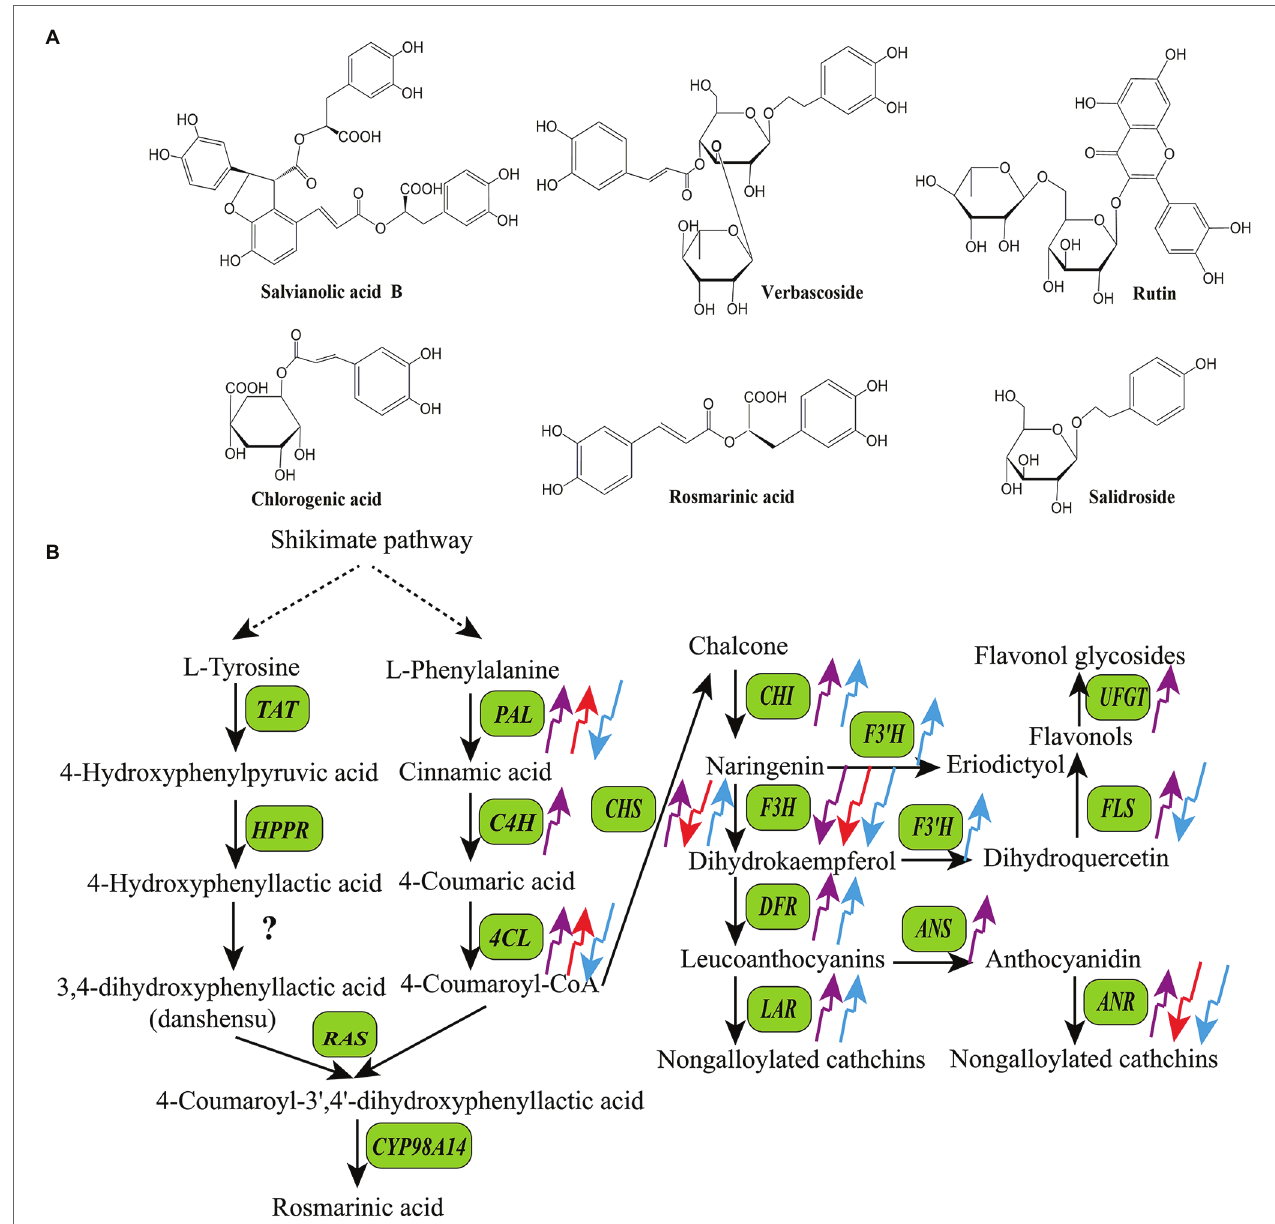
FIGURE 1 | Structures of some bioactive polyphenols in medicinal plants (A) and the effects of light quality on the transcripts of key enzyme genes in the biosynthetic pathways of polyphenols (B) . The upward arrows indicate upregulation and the downward arrows indicate downregulation. The purple arrow, red arrow, and blue arrow indicate UV-B, red light, and blue light, respectively. ANR , anthocyanidin reductase; ANS , anthocyanidin synthase; CHS , chalcone synthase; CHI , chalcone isomerase; CYP98A14 , cytochrome p450 98A14; C4H , cinnamic acid 4-hydroxylase; DFR , dihydroflavonol 4-reductase; FLS , flavonol synthase; F3 ′ H , flavonol 3 ′ -hydroxylase; F3H , flavanone 3-hydroxylase; HPPR , 4-hydroxyphenylpyruvate reductase; LAR , leucoanthocyanidin reductase; PAL , phenylalanine ammonia-lyase; RAS , rosmarinic acid synthase; TAT , tyrosine aminotransferase; UFGT , UDP flavonoid glucosyltransferase; 4CL , 4-coumaric acid: CoA